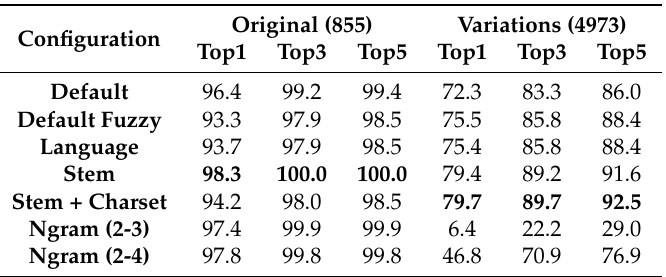
Table 3. Proportion of original questions and variations correctly matched with original FAQs (Top1), in Top-3 and in Top-5 most similar, using different configurations of Whoosh.